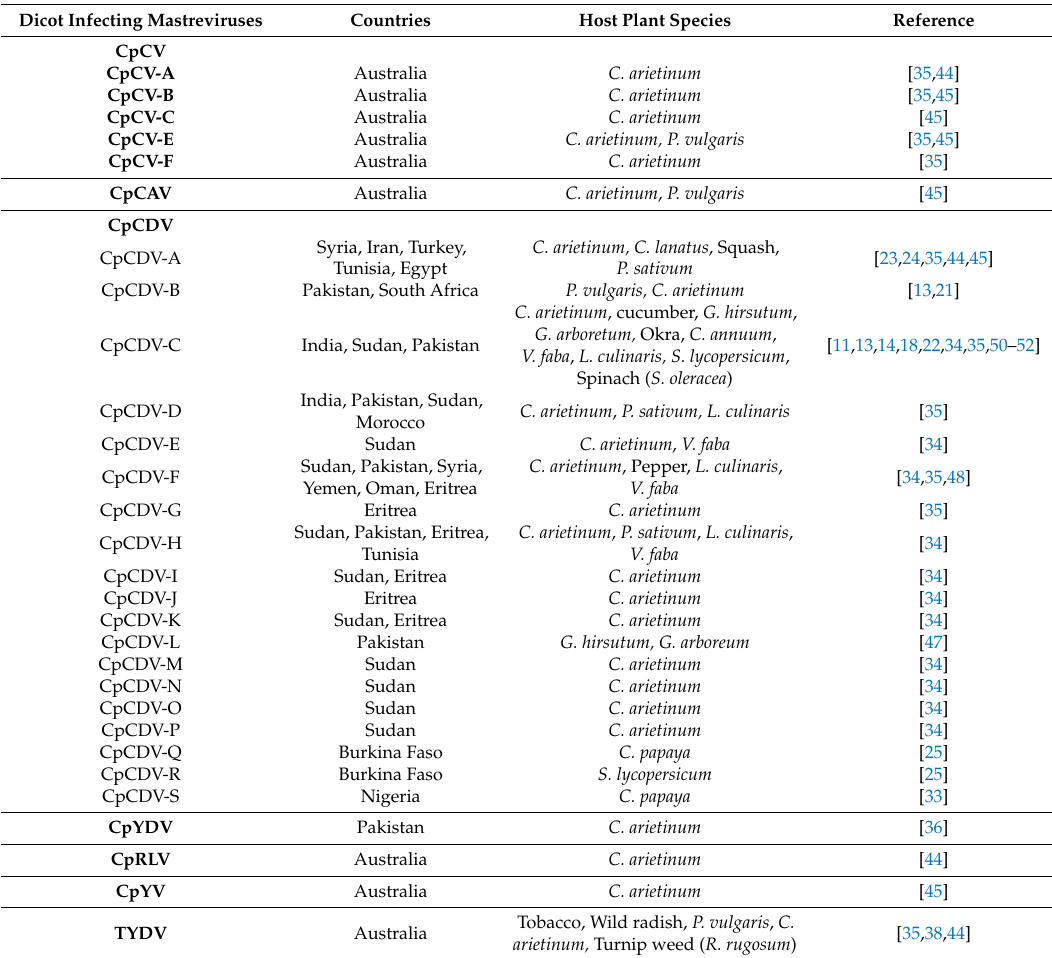
Table 1. Geographical distribution and host range of dicot infecting